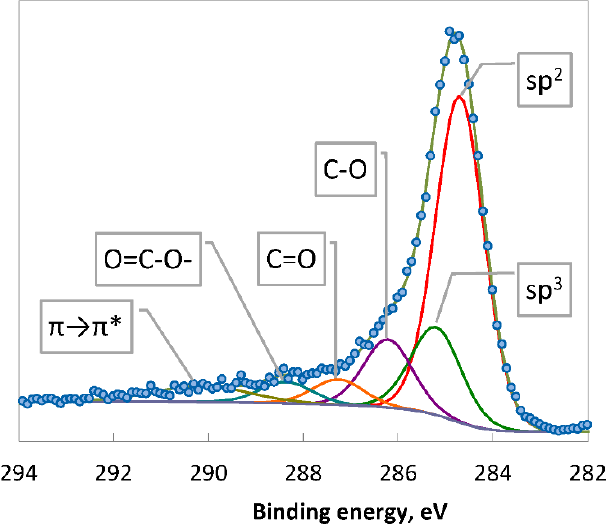
Figure 3. High-resolution X-ray photoelectron spectrum of C 1s peak of polyimide-derived carbon obtained with phosphoric acid at 800 °C.